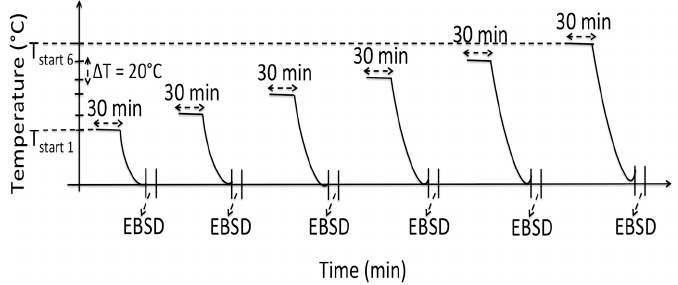
Figure 2. Cyclic annealing schedule with increasing isothermal dwelling anneals used in this study. (Reproduced with permission from [19], © 2016 ASM International and Springer Science + Business Media New York, 2016; EBSD: Electron backscatter diffraction.)